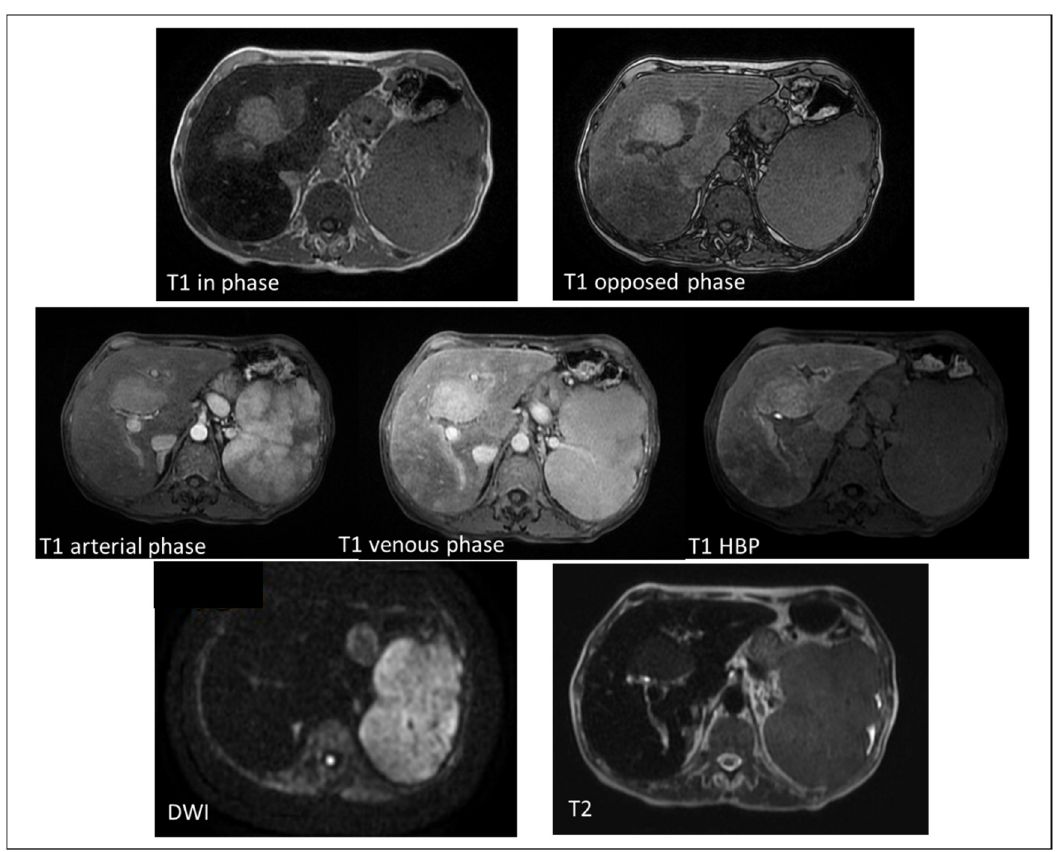
Figure 2. MRI imaging of a 72-year-old female with secondary hemochromatosis, showing a nodular area in the IV segment. The area, adjacent to portal bifurcation, appeared as hyperintense in com- parison to the surrounding liver parenchyma both in T1 in phase and opposed phase imaging. The liver parenchyma appears less hypointense in the T1 opposed phase (TE = 2.4 ms) than in the T1 in-phase image (TE = 4.8 ms) due to the iron overload. The lesion was also slightly hyperintense in T2 weighted images without restriction on DWI sequences. After the administration of contrast agent (Gd-EOB-DTPA), it seemed to have hyperenhancement on arterial phase without wash-out in venous phase. In the hepatobiliary (HBP), it appeared hyperintense. This lesion turned out to be a nodular area of iron